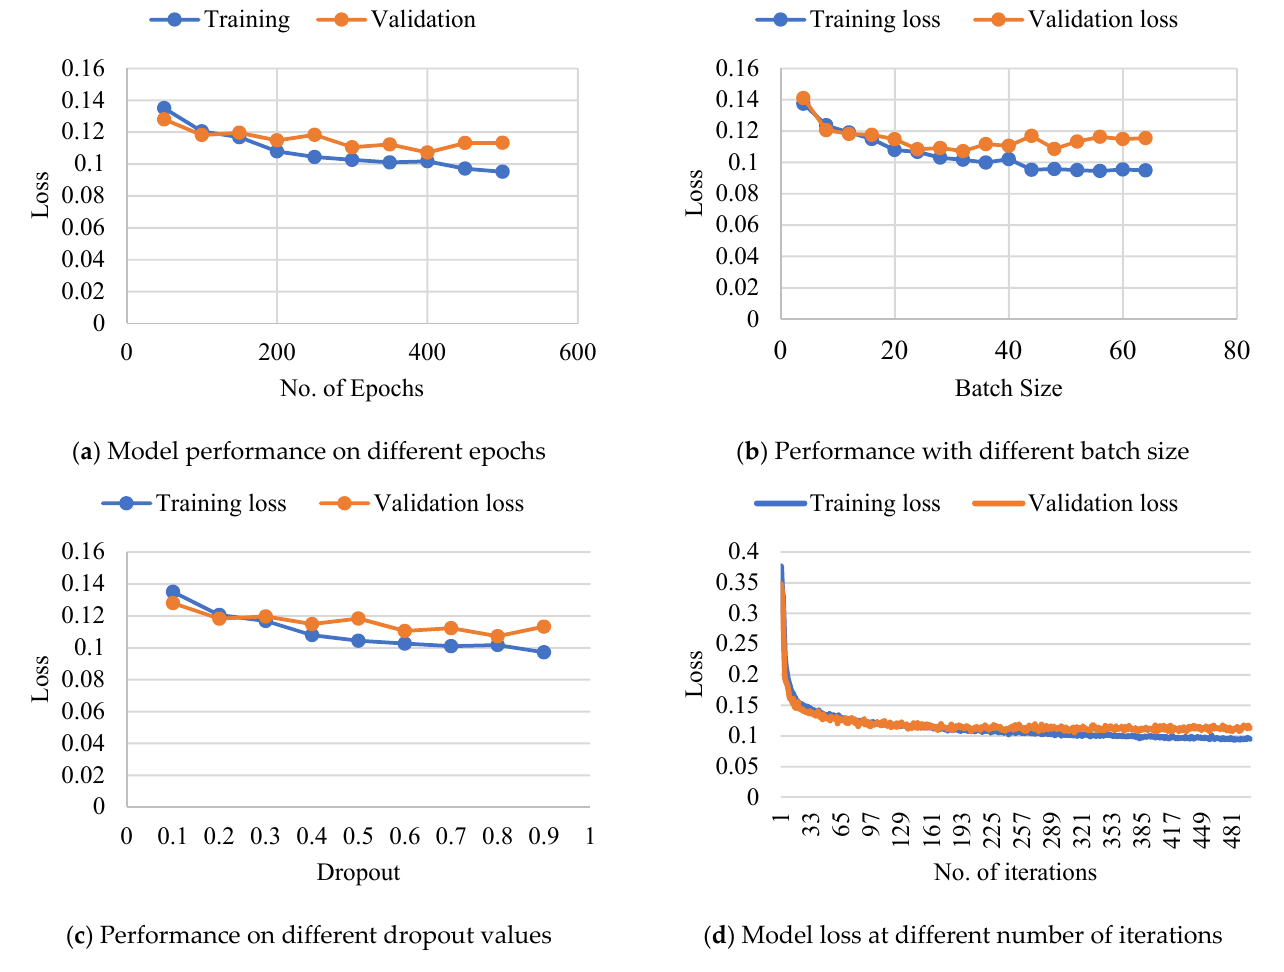
Figure 5. Model performance using different values of epochs in ( a ), batch size in ( b ), dropout in ( c ), and iterations in ( d ).